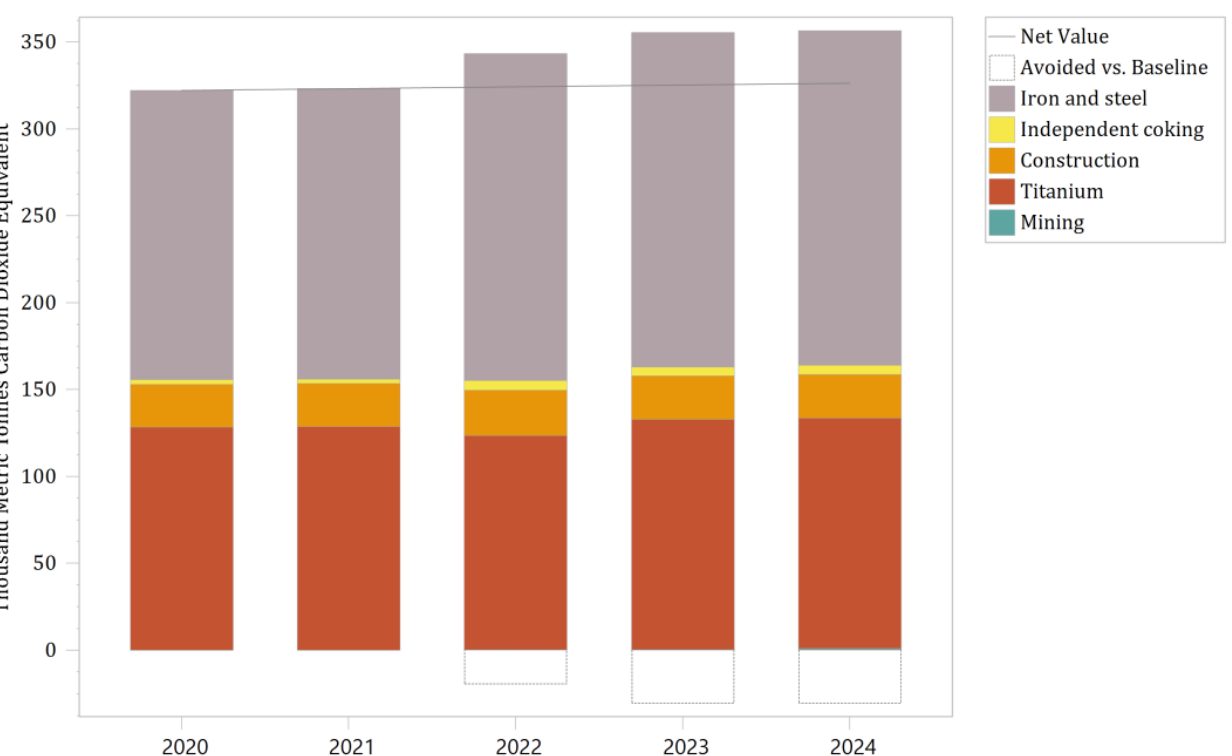
Table 9. Indirect carbon emissions from key industrial modules under the pollutant treatment up- grade treatment scenario and differences from the baseline scenario . Branch.